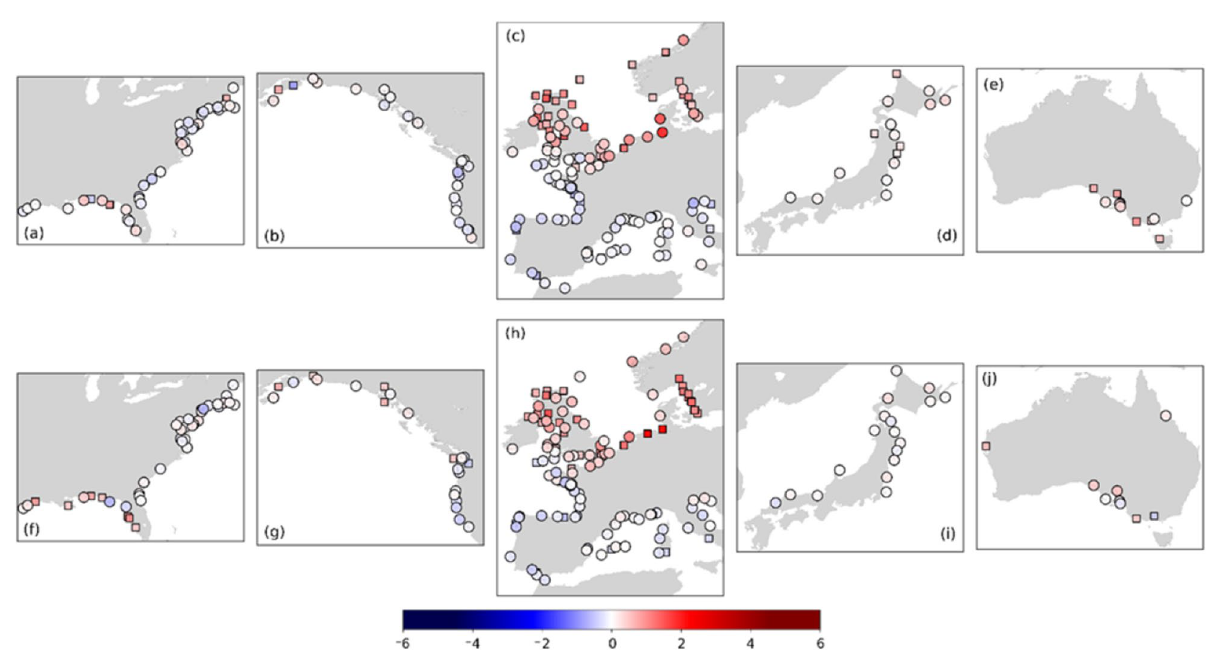
Figure 6. Trends (mm/year) for the annual 99th percentile surge values for G-20CR ( a – e ) and G-E20C ( f – j ) corresponding to 1950–2015 and 1950–2010 respectively. Rectangle markers indicate significant trends at the 5% significance level. Rossum, Guido van, et al., The Python Language Reference, Python Software Foundation; http:// docs. python. org/ py3k/ refer ence/ index.